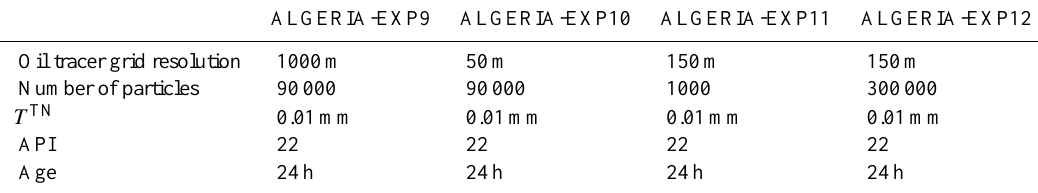
Table 6. Table of experiments designed to study the model’s sensitivity to the horizontal resolution of the oil tracer grid and to the number of